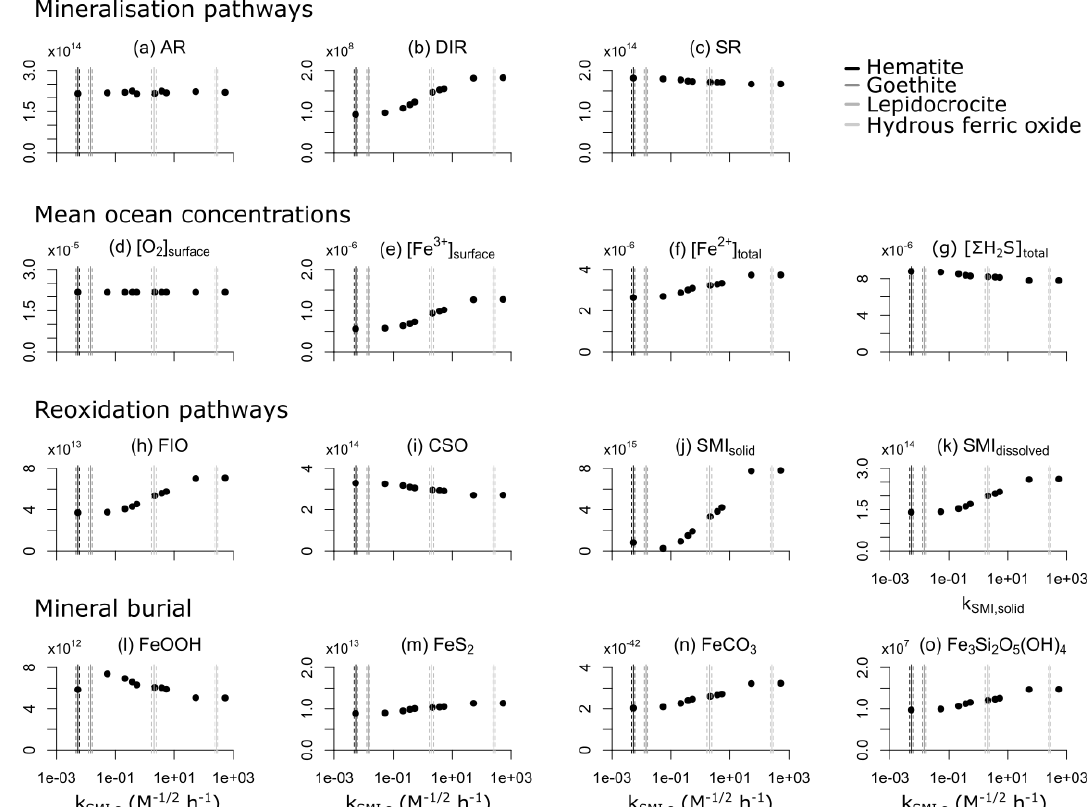
Figure 13. Global model output for a range of k SMI , s values (units are M − 1 / 2 h − 1 ). Lines indicate experimental reactivity parameters as presented in Poulton et al. (2004). Panels (a) – (c) and (h) – (n) are in moles per year (molyr − 1 ), and panels (d) – (g) are in moles per kilogramme (molkg − 1 ). Note that the x axis is